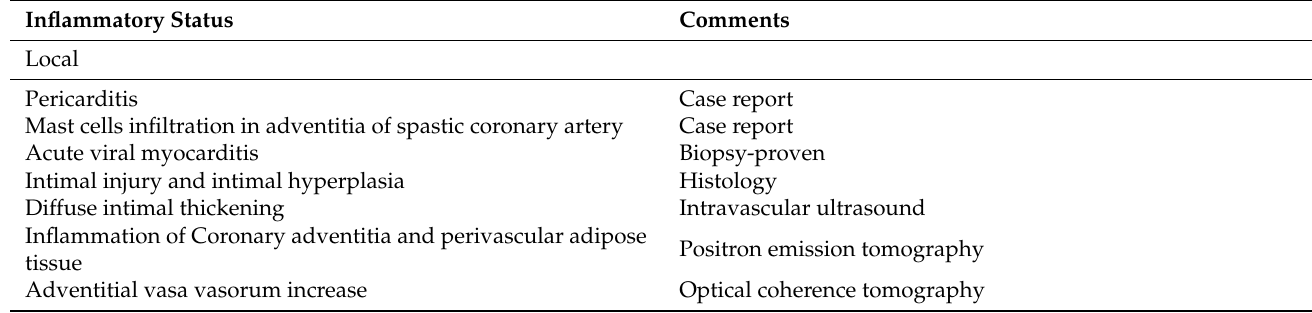
Table 1. Relationship between inflammation and vasospastic